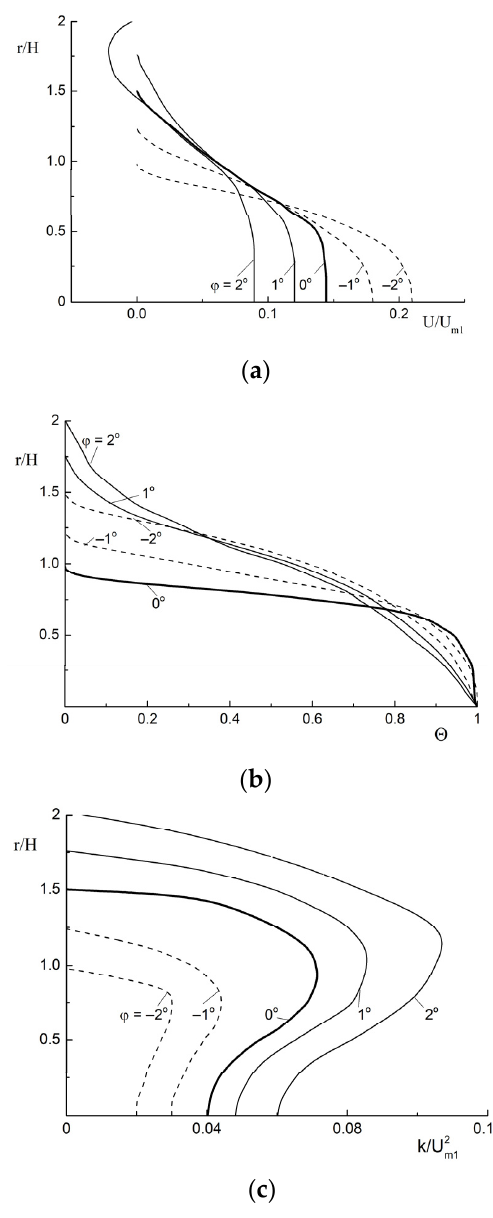
Figure 4. Mean streamwise velocity component ( a ), temperature ( b ), TKE ( c ) of the gas phase in ZPG ( φ = 0°), confuser (FPG, φ < 0°), and diffuser (APG, φ > 0°). The results for the confuser are the dashed lines, for the diffuser are the solid curves, and the separated flow with φ = 0° are the bolded lines. M L 1 = 0.05, d 1 = 30 μ m.